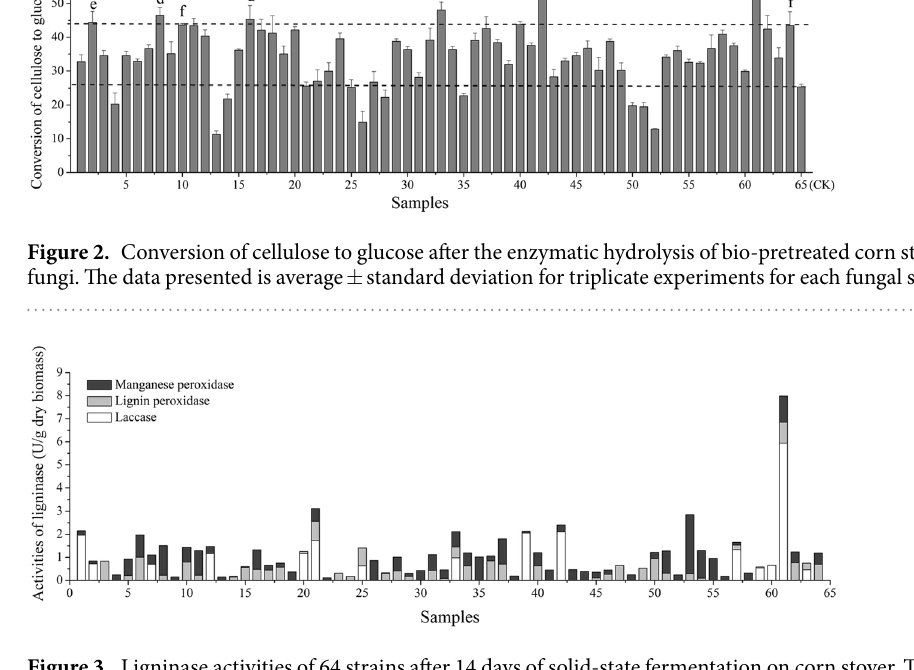
Figure 3. Ligninase activities of 64 strains after 14 days of solid-state fermentation on corn stover. The data presented is average ± standard deviation for triplicate experiments for each fungal strain. No. 1 to No. 63 stand for screened strains and No. 64 stands for the classic